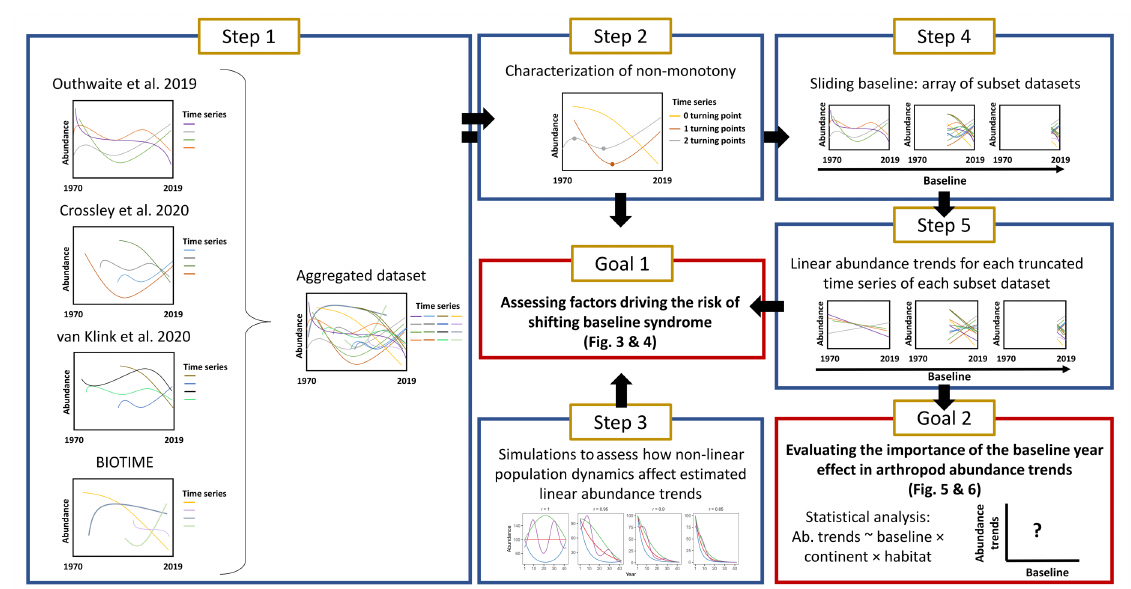
Figure 2: Schematic description of data aggregation, and workflow of analyses to assess the effect of the temporal baseline on abundance trends. In Step 1, we aggregated empirical datasets from four different source datasets. Then we characterized non-monotony of abundance variations over time (Step 2), and we assessed how non-monotony can affect estimated linear abundance trends using simulations (Step3, Goal 1). Finally, we created an array of subset datasets using a sliding baseline (Step 4) to estimate how baseline years influenced estimated linear abundance trends in empirical data (Step 5, Goal 2). Abundance trends are expressed as growth rates for all time series, allowing comparisons among common and rare species, as well as among datasets (cf. Supplementary Methods, Fig. S2 & S3). Statistical analyses were then performed accounting for habitat (aquatic vs. terrestrial), continent, data source and